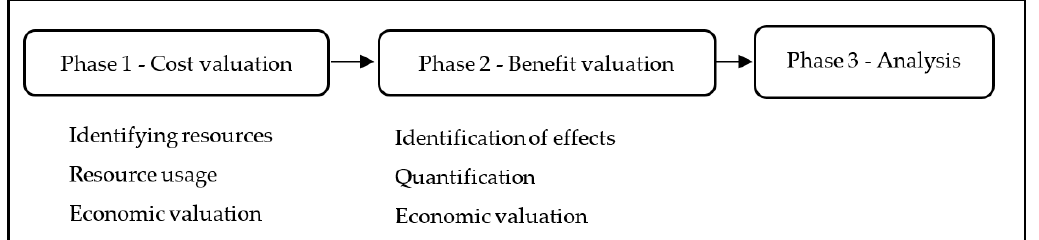
Figure 2. Phases of the cost-benefit analysis.